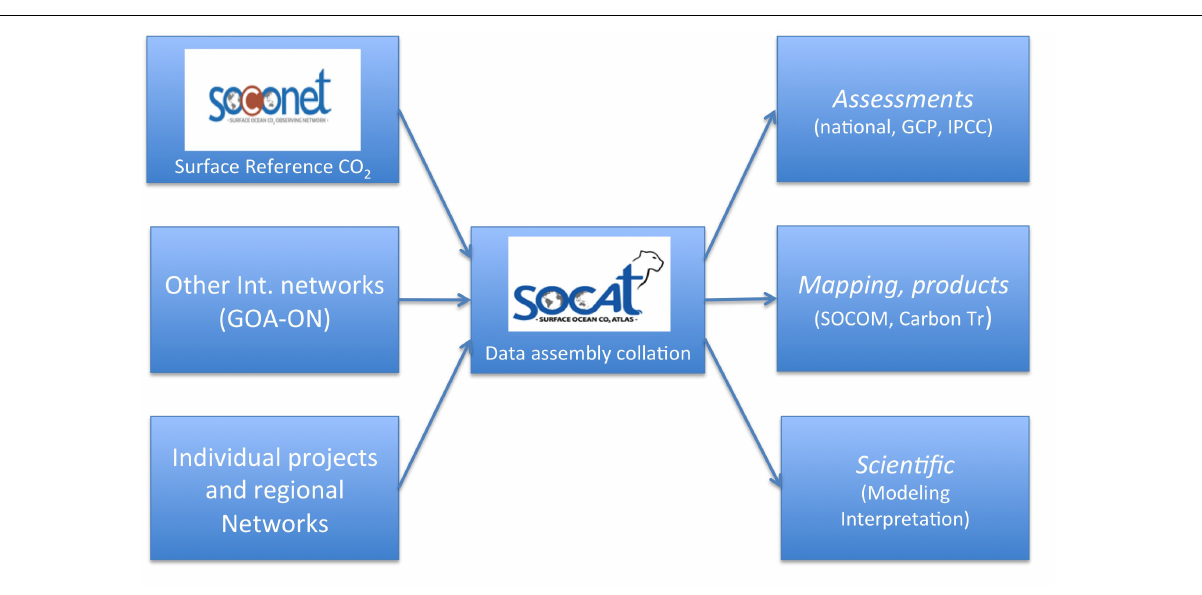
FIGURE 2 | Flow diagram that shows the relationship between SOCONET, SOCAT and other